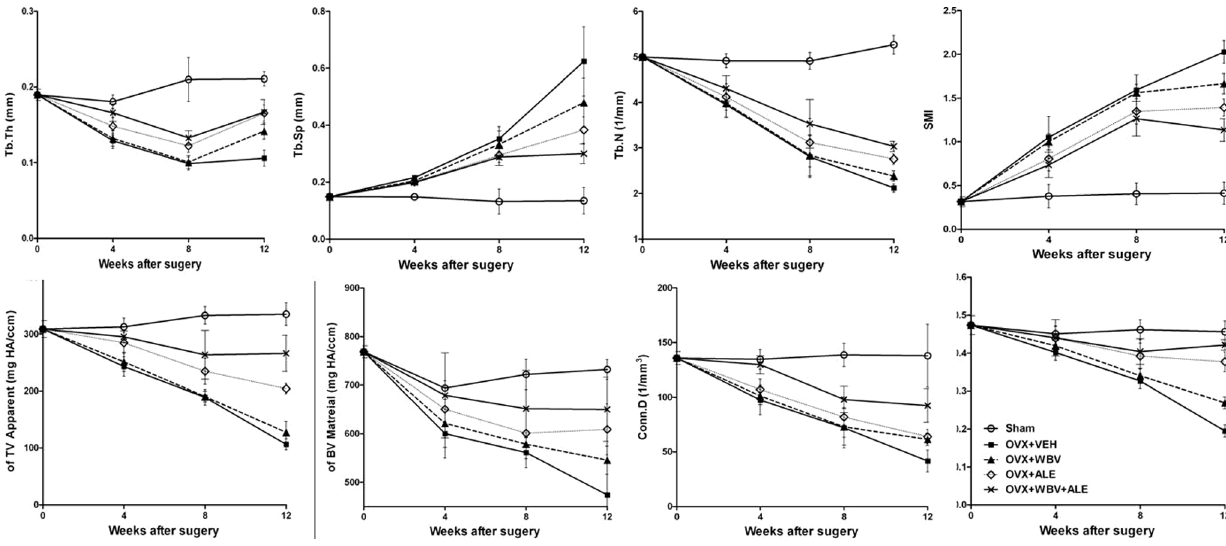
Figure 3. Morphological parameters of trabecular changes throughout the experiment as measured using m CT. Each value was derived from a single serial cross-section obtained from the left tibia of the rats. Data were presented as the mean 6 SD.